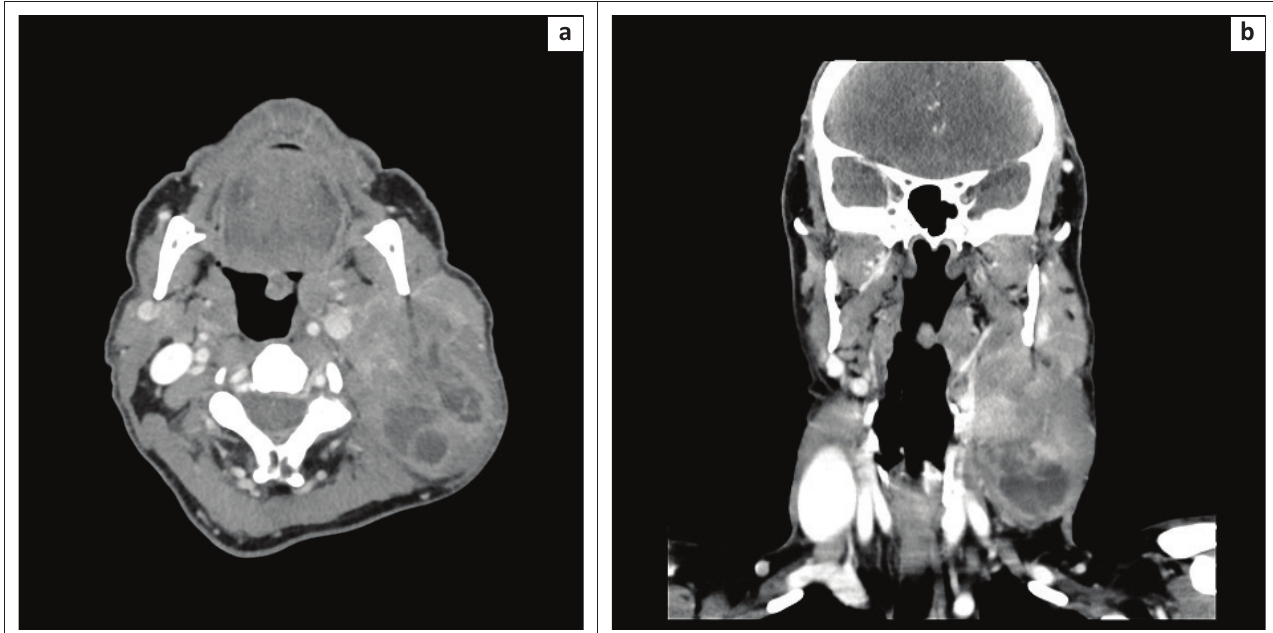
FIGURE 1 : (a) Axial contrasted computed tomography (CT) scan demonstrates a small ovoid iso-attenuating mass in the left tonsil. The large mixed solid–cystic nodal-mass conglomerate in the left side of the neck exerts mass effect on the left carotid space and displaces it medially. (b) Coronal contrasted CT scan demonstrates the cranio- caudal extent of the nodal-mass conglomerate in the left side of the neck. The cranial aspect is solid and enhancing, and the caudal portion is cystic and multiseptated.